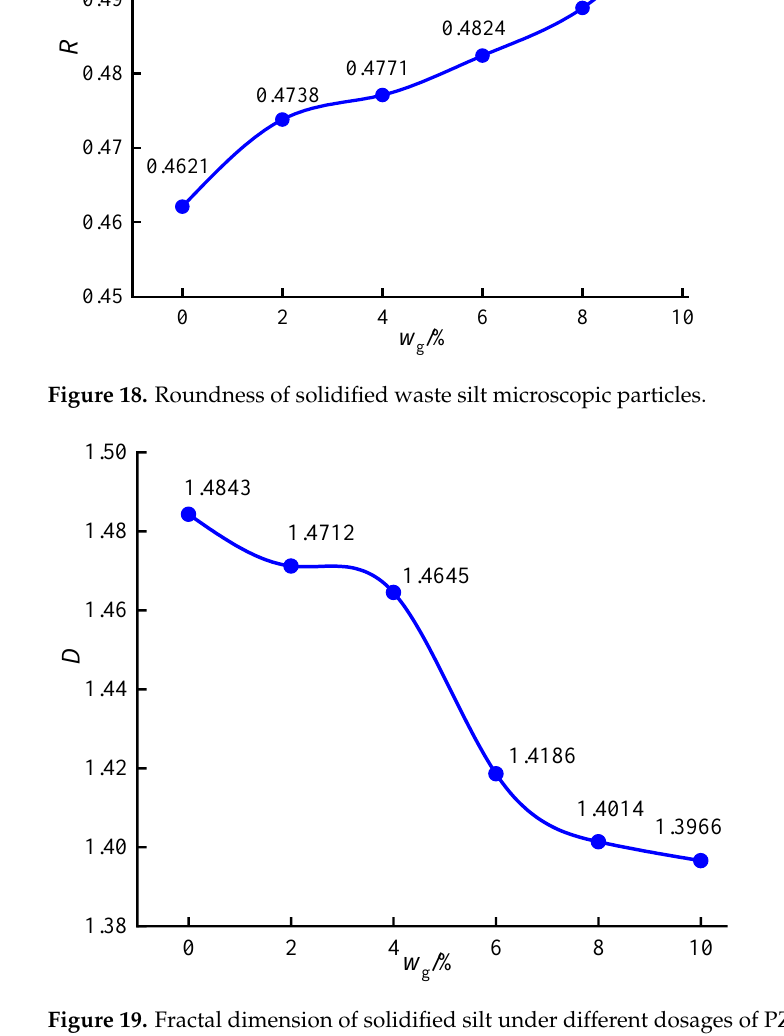
Figure 19. Fractal dimension of solidified silt under different dosages of PZ – 1.